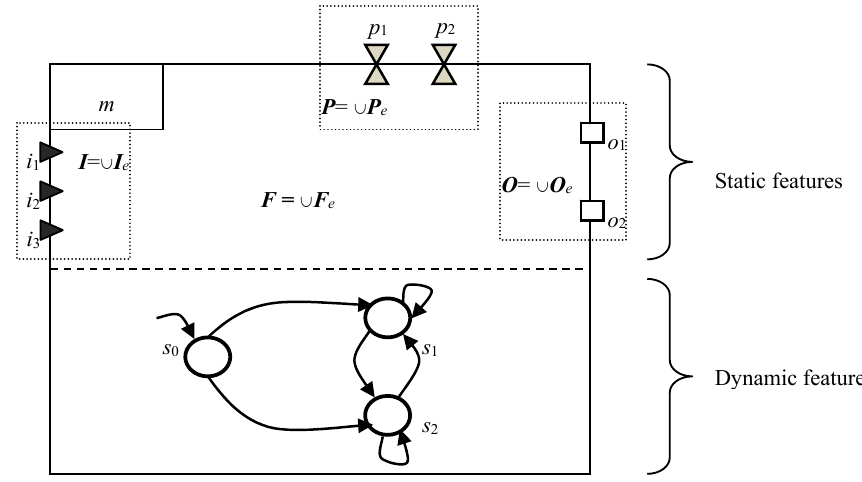
Figure 3. The diagram definition of the model.